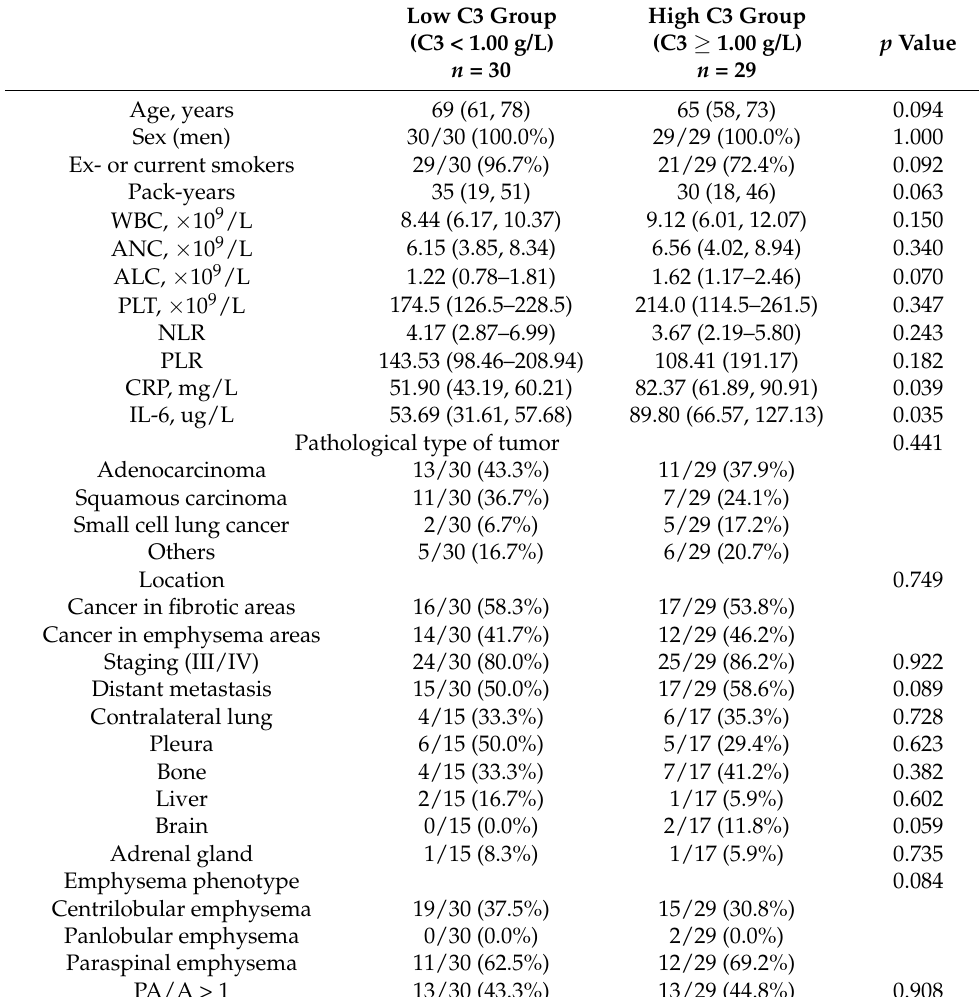
Table 4. Comparisons between the low and high C3 groups of lung cancer patients with